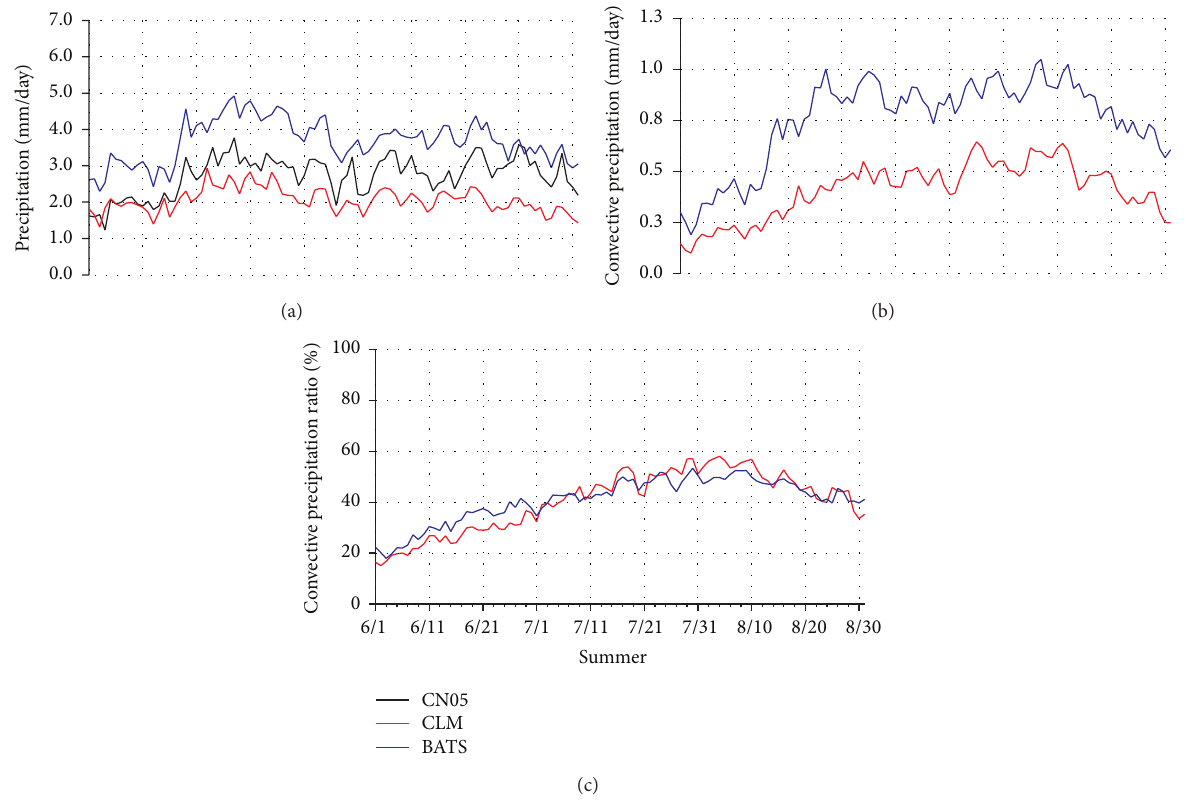
Figure 7: The observed and simulated summer daily precipitation (a), convective precipitation (b), and convective precipitation ratio (c) over the TP during 1992–2001. The ratio is defined as the ratio of the summer convective precipitation to the summer precipitation in the two